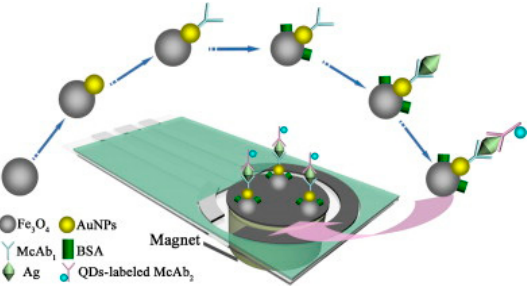
Figure 6. Schematic representation of the CEA ECL immunosensor developed by Wang, S. et al. [89]. Reproduced and adapted with permission of Elsevier.